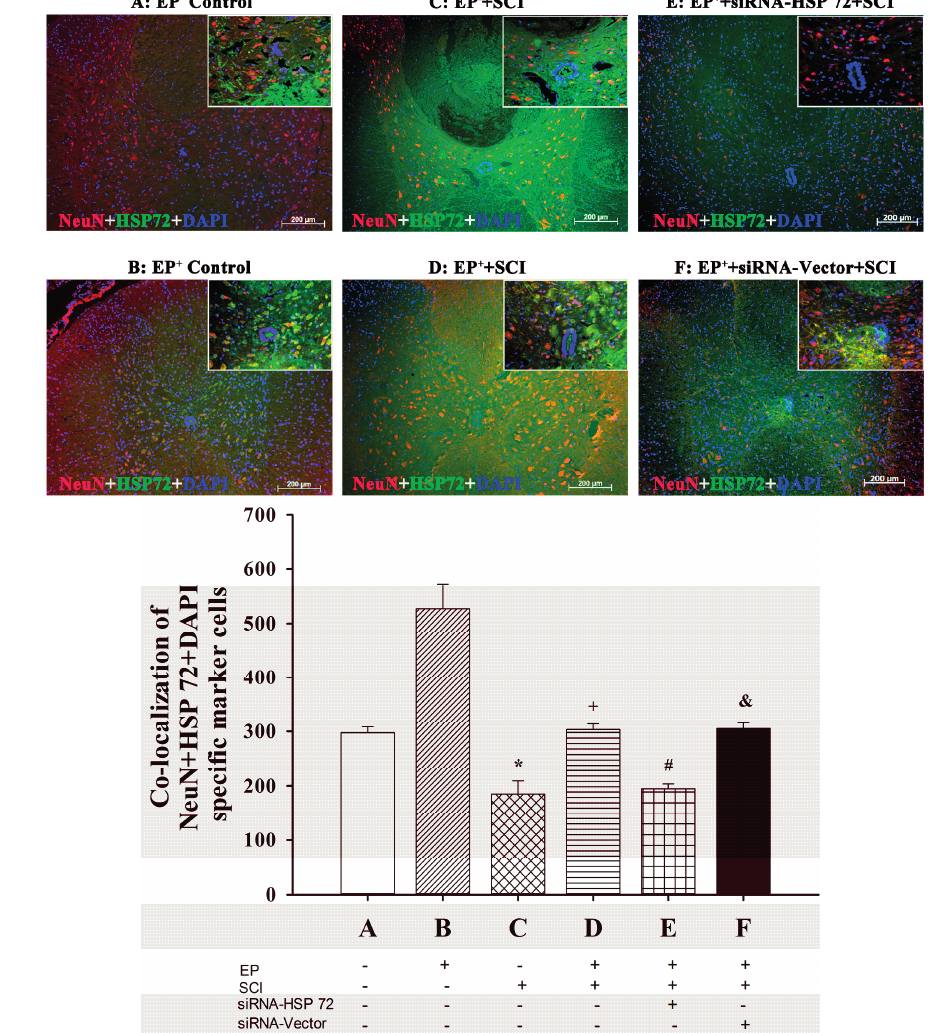
(Figure 6a) and more GFAP + HSP 72 double-positive cells (Figure 7b) than did the EP − + SCI group rats (D vs. C). Rats in EP + + siRNA-HSP + SCI group had significantly lower numbers of both NeuN + HSP 72 double-positive cells (Figure 7a) and GFAP + HSP 72 double-positive cells (Figure 7b) than did the EP + + SCI group or the EP + + siRNA + vector + SCI group. Figure 7. Immunofluorescence detection of HSP 72-positive neurons ( a ) and HSP 72-positive astrocytes ( b ) in the gray meter after spinal cord injury. HSP 72-positive neurons and HSP 72-positive astrocytes were revealed using double (anti-HSP 72 + anti-neuN) stains and double (anti-GFAP + anti-HSP 72) stains, respectively. The numbers of both HSP 72-positive neurons and HSP 72-positive astrocytes in the lesioned sites were calculated and summed 7 days after injury or sham operation. Please see the legends of Figure 1 for group abbreviations. The immunofluorescences presented are representative of results from different groups of animals. Values represent mean ± SD of 8 rats per group. * p < 0.01 for C vs. A or B; + p < 0.05 for D vs. C; # p < 0.05 for E vs. D; & p < 0.05 for F vs. E. The ruler for the insert image is